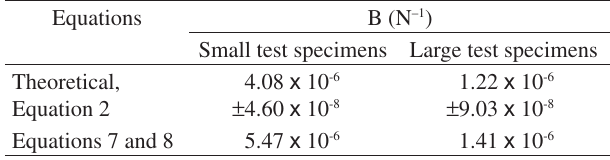
Figure 2. Compliance calibration curves, C, versus crack (or notch) length, a, for large and small test specimens. Table 4. Theoretical and experimental values of B of the castable under study for the two test specimen